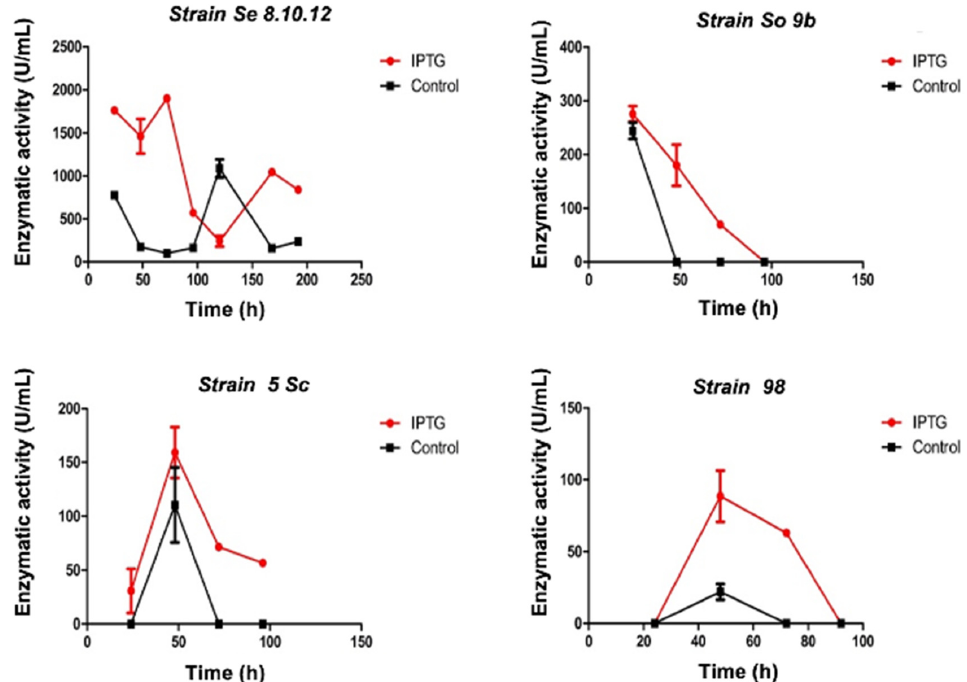
Figure 1. β -galactosidase activity quantified from enzyme extract of four Antarctic strains (specified in each graph title) at 15 ◦ C reaction in the presence (red lines) and absence (black lines) of IPTG inducer. Error bars display the standard deviation of the